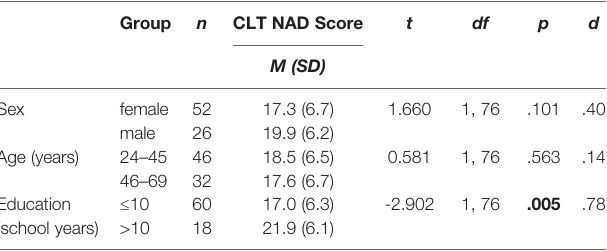
TABLE 2 | Cards and Lottery Task: The number of advantageous decisions (NAD score) by sociodemographic group. Group